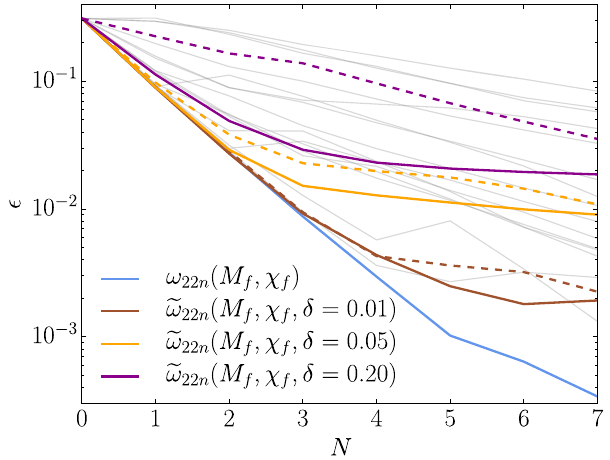
FIG. 7. The root-mean-squared error ϵ defined in Eq. (4), for different sets of frequencies, as a function of the number of included overtones N . The fits are performed on the spherical l ¼ m ¼ 2 mode at t ¼ t t . The label ω 22 n ð M f ; χ f Þ 0 ¼ peak represents the set of frequencies consistent with perturbation theory, while ˜ ω 22 n ð M f ; χ f Þ represents the set of frequencies with the fundamental mode, n ¼ 0 , unmodified but with a slight modification to the overtone frequencies by a factor of ( 1 þ δ ). For each δ , there is an associated dashed line of the same color that corresponds to δ → − δ . The faint grey lines correspond to frequencies with a random δ for each n , as explained in the last paragraph of Sec. IVA. The results suggest that there is information present in the overtones that contributes to extracting the remnant properties at the peak, as these outperform a similar set of functions, with the same d.o.f. for each N but with frequencies inconsistent with the asymptotic remnant.